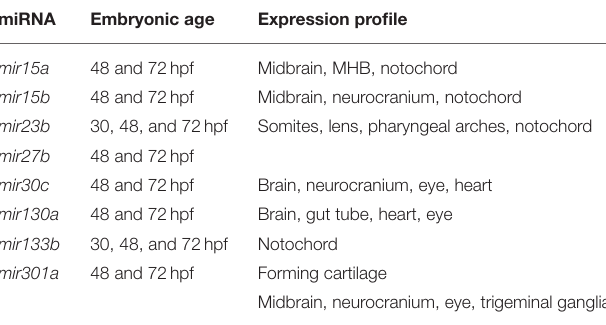
TABLE 3 | Expression profiles of miRNAs in the developing zebrafish.